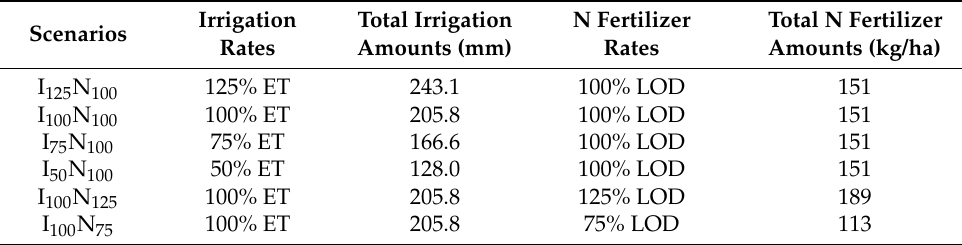
Table 1. Irrigation and N fertilizer rates in six surface drip fertigation (SDF) scenarios. Irrigation Scenarios